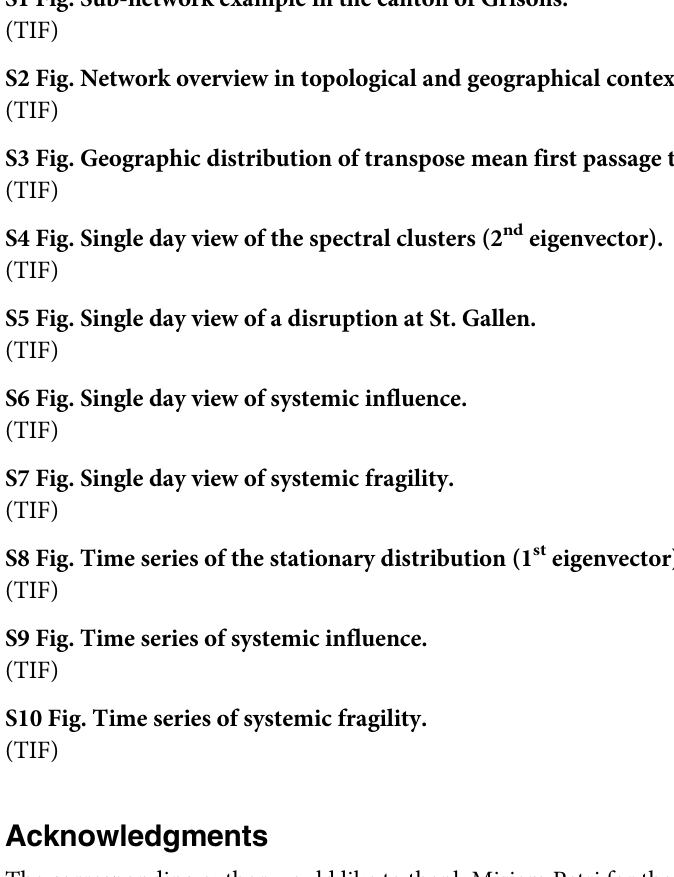
S1 Fig. Sub-network example in the canton of Grisons. S2 Fig. Network overview in topological and geographical context. S3 Fig. Geographic distribution of transpose mean first passage time. S4 Fig. Single day view of the spectral clusters (2 nd eigenvector). S5 Fig. Single day view of a disruption at St. Gallen. S6 Fig. Single day view of systemic influence. S7 Fig. Single day view of systemic fragility. S8 Fig. Time series of the stationary distribution (1 st eigenvector). S9 Fig. Time series of systemic influence. S10 Fig. Time series of systemic